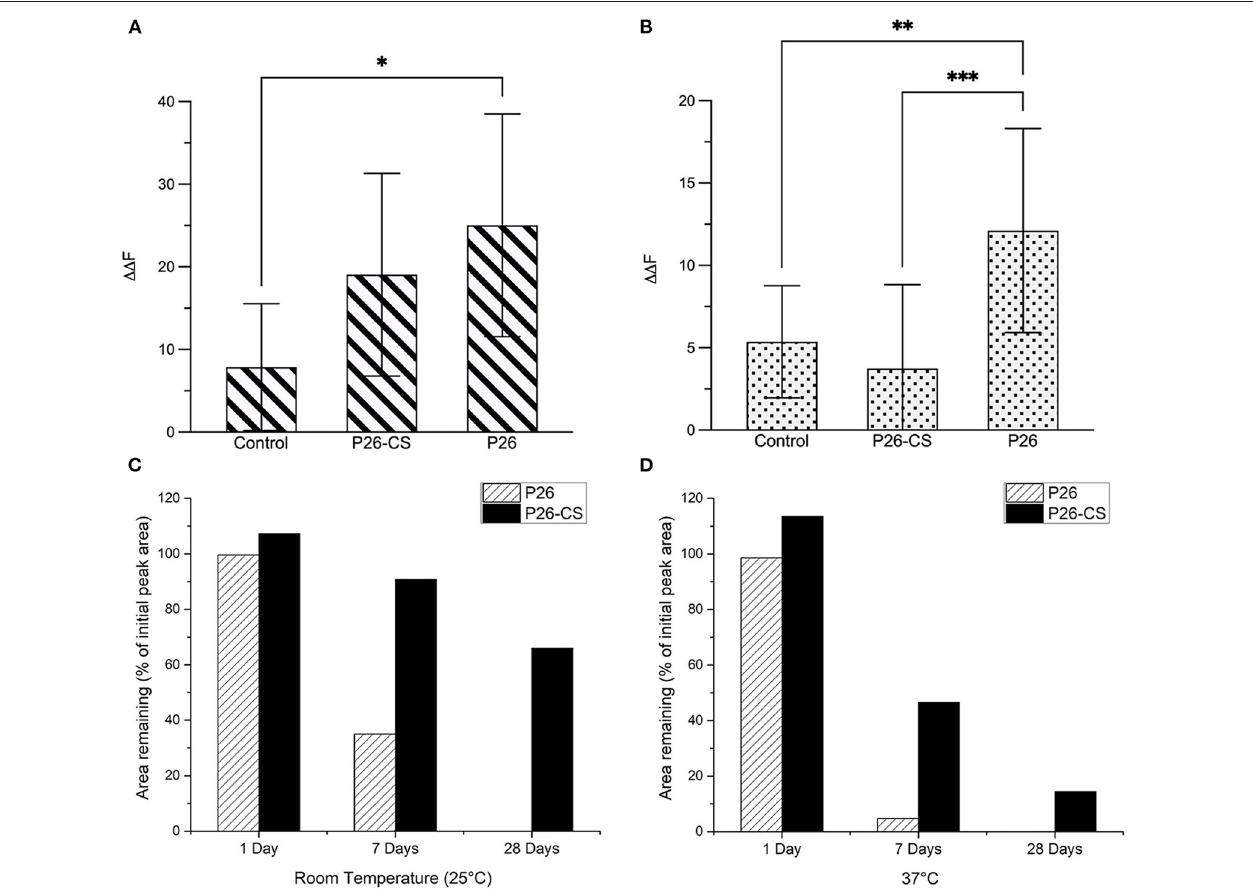
FIGURE 4 | Evaluation of Remineralized Enamel Mineral Density and stability of amelogenin peptides. Comparative quantitative analysis of 11 F remin between the three experimental groups before and after remineralization: control, P26-CS and P26. In enamel sections (A) there was no significant difference between the P26 solution and P26-CS treatment group ( p > 0.05). In enamel blocks (B) there was a highly significant difference between P26 solution and control group ( p < 0.007). Percentage of peptide remaining after 1, 7, and 28 days in P26 and P26-CS solutions ( n = 3 per group) incubated at room temperature (C) and 37 ◦ C (D) . While